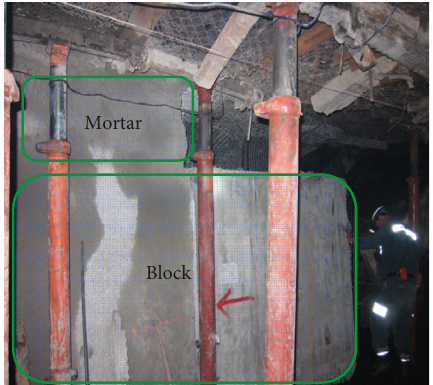
Figure 8: Picture of pressure-releasing support wall.